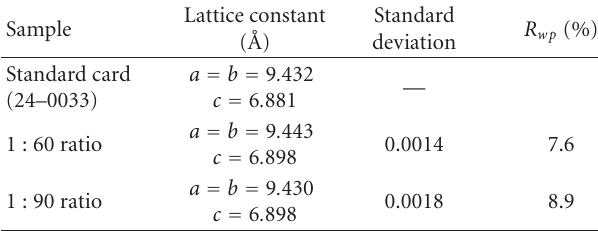
Table 1: Unit cell parameters of the mechanical milled HA.